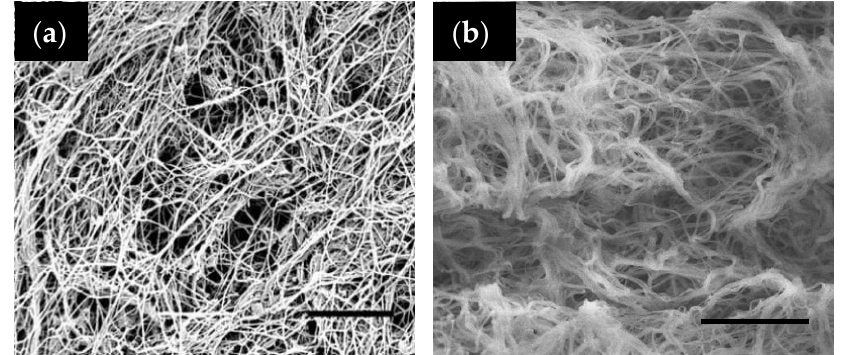
Figure 3. SEM images of ( a ) type I tropocollagen hydrogel at 5 mg mL −1 and ( b ) fibrin hydrogel at 6 mg mL −1 . Scale bar: 5 μm for both images. ( a ) is reproduced with permission from [55]. Copyright 2010 John Wiley & Sons, Ltd.